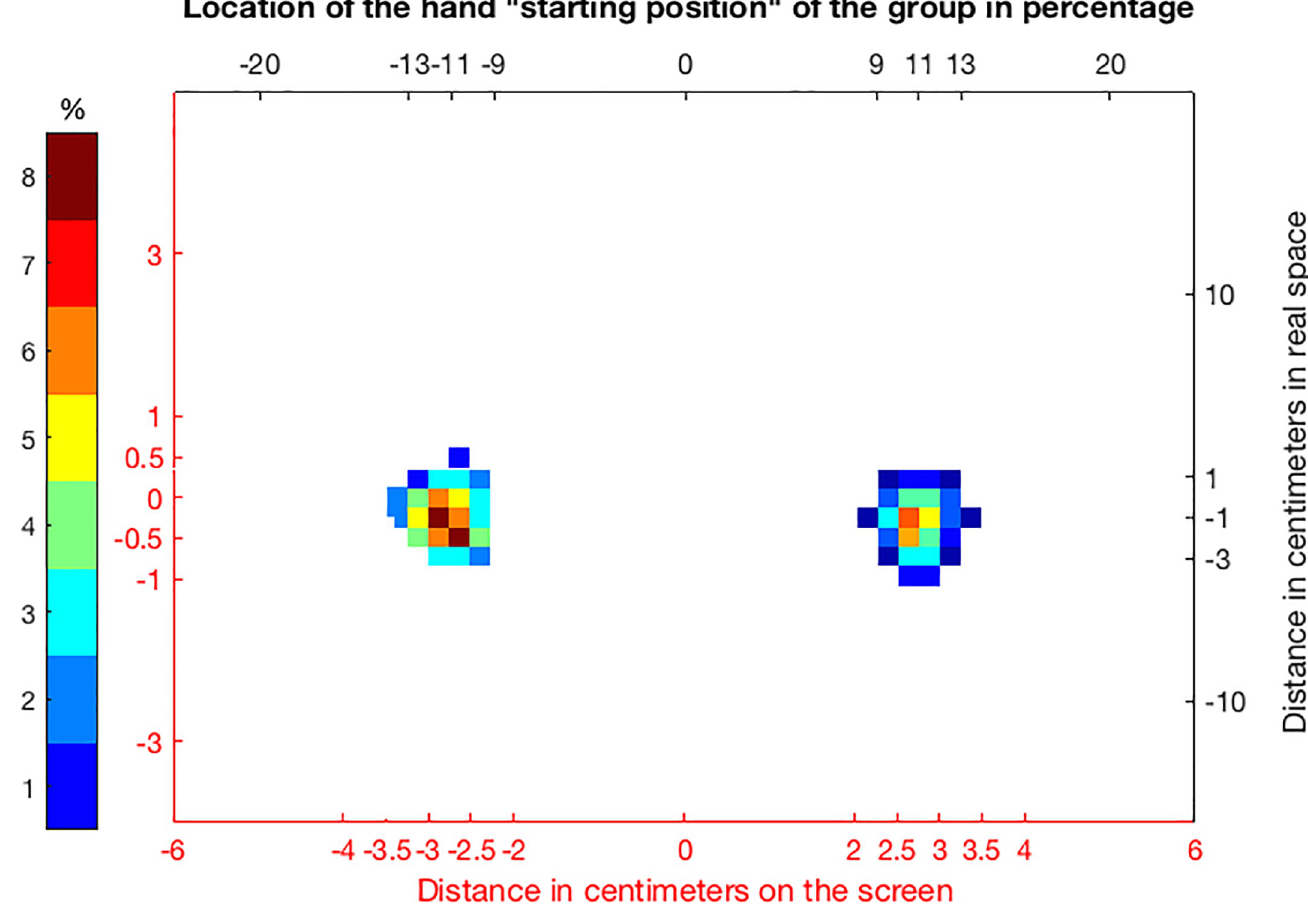
Fig 6. Mean probabilities of hand locations at the start of a trial. The plot shows the mean probability of a given hand location at the start of a trial across participants. Red axes indicate positions in centimeters on the screen (visual2D), while black axes indicate positions in real space (please refer to Figs 1 and